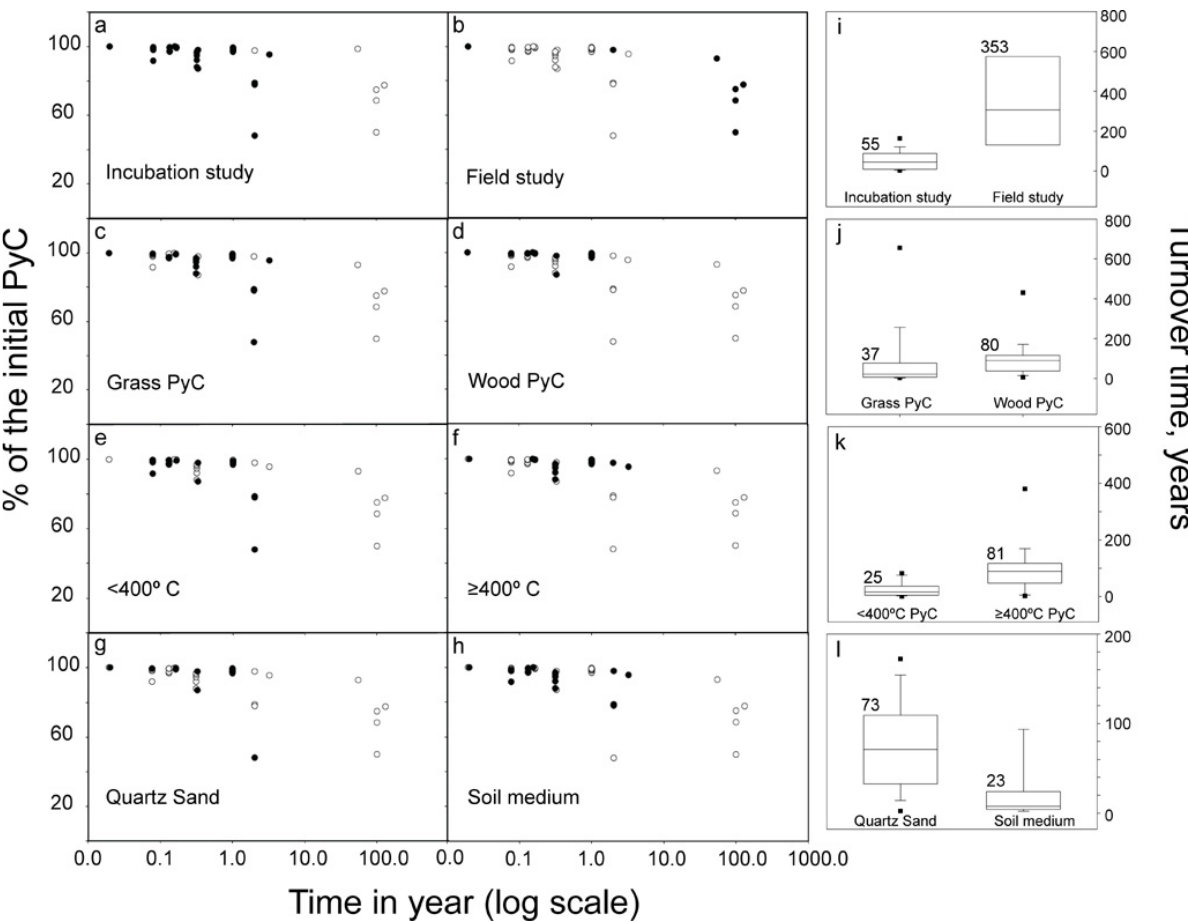
Fig. 3. Pyrogenic stock expressed as percentage of the initial from the data reported in literatures. Circles represent all data points and solid circles represent the grouped data set, namely (a) incubation study, (b) field study, (c) grass PyC, (d) wood PyC, (e) pyrolysis temperature < 400 ◦ C, (f) pyrolysis temperature ≥ 400 ◦ C, (g) sand medium and (h) soil medium. The time is expressed in years (log scale). The box plot (right) of turnover time of each variable (i) – (l) , where squares are outliers beyond 5th or 95th percentiles and numbers denote average turnover time. The calculated turnover time varies from decades to